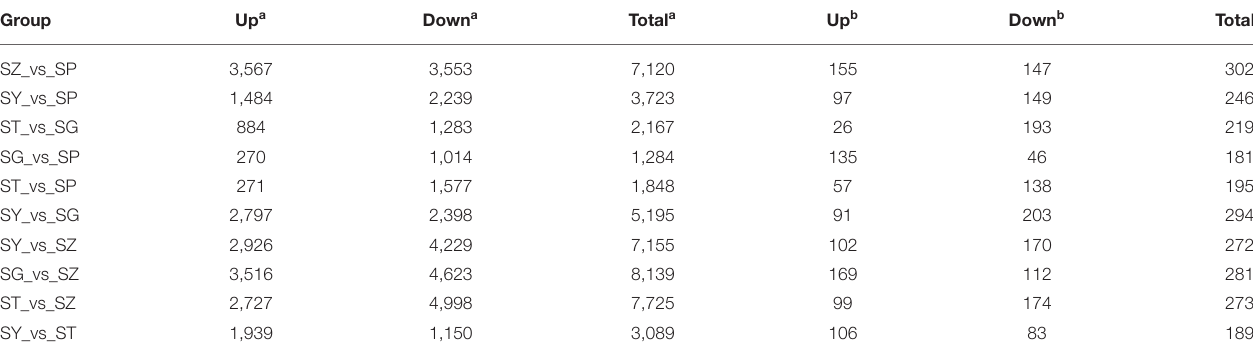
TABLE 1 | Summary of the DEGs and DAMs among 10 library pairs.